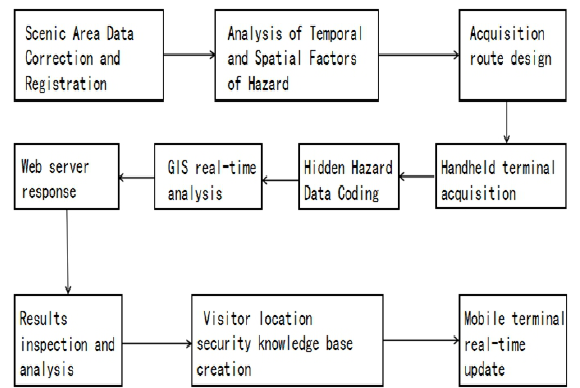
Figure 1. Flow chart of real-time acquisition and analysis method for potential position safety hazard